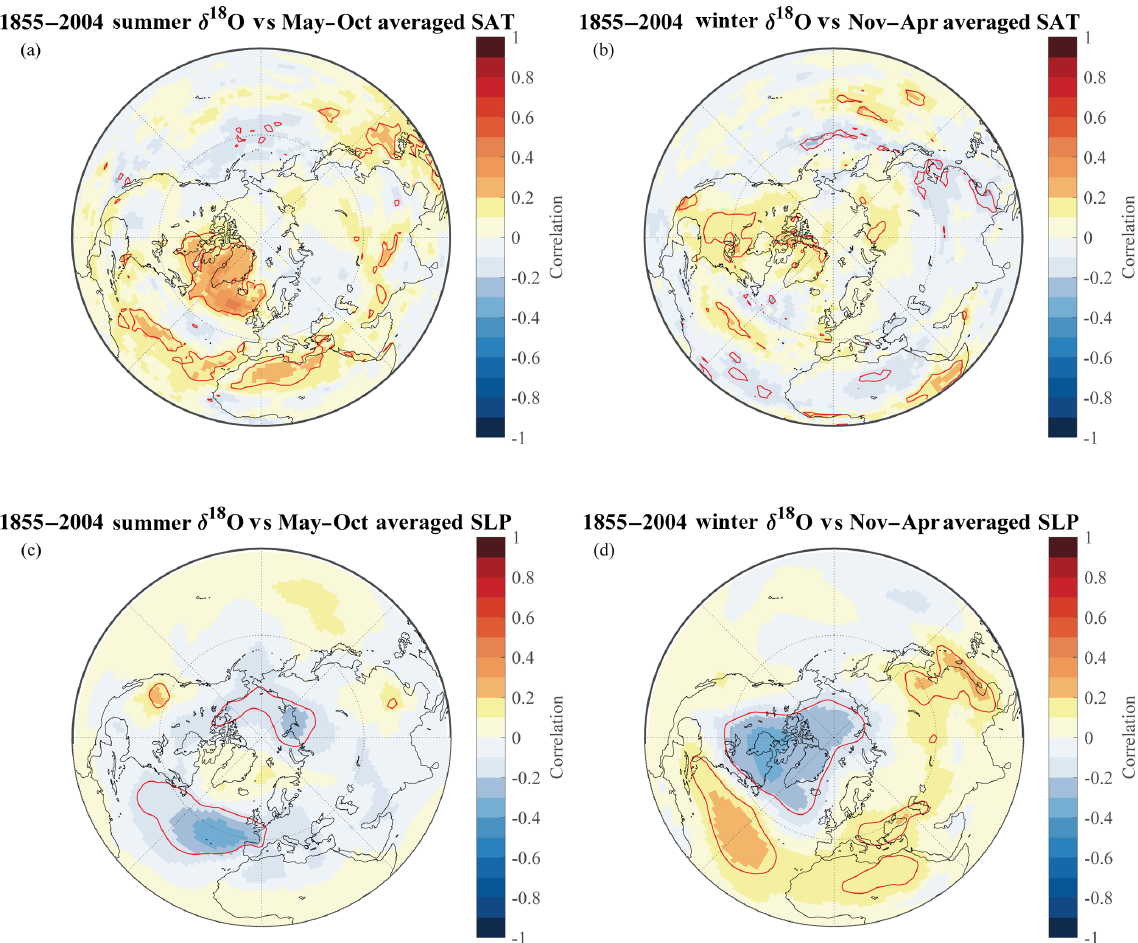
Figure 5. The spatial correlation map between NEEM seasonal δ 18 O and SAT (a, b) and SLP (c, d) from 20CR reanalysis data for the period 1855–2004. The winter data are averaged for November–April and the summer data are averaged for May–October. The red solid lines indicate significant correlation at the 95% confidence level ( t